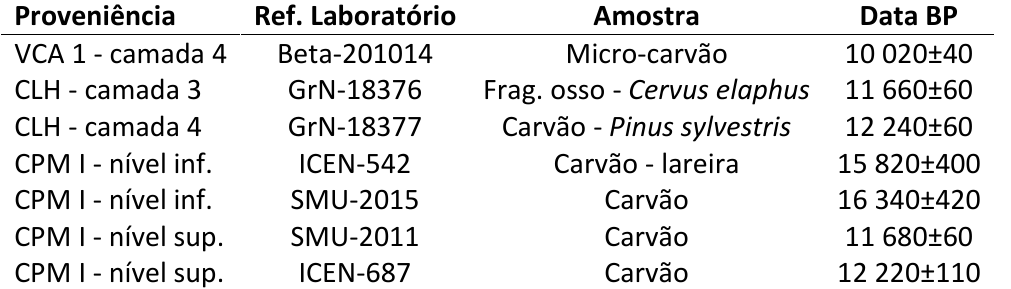
Tabela 2. Datações radiométricas correspondentes às camadas dos sítios arqueológicos apresentados: VCA1 - Abrigo 1 de Vale Covões (Aubry et al. 2008); CLH - Lapa dos Coelhos (Almeida et al. 2004); CPM I - Cabeço de Porto Marinho I (Zilhão 1997). Table 2. Radiometric dates corresponding to the layers of the archaeological sites presented: VCA1 - Abrigo 1 de Vale Covões (Aubry et al. 2008); CLH - Lapa dos Coelhos (Almeida et al. 2004); CPM I - Cabeço de Porto Marinho I (Zilhão